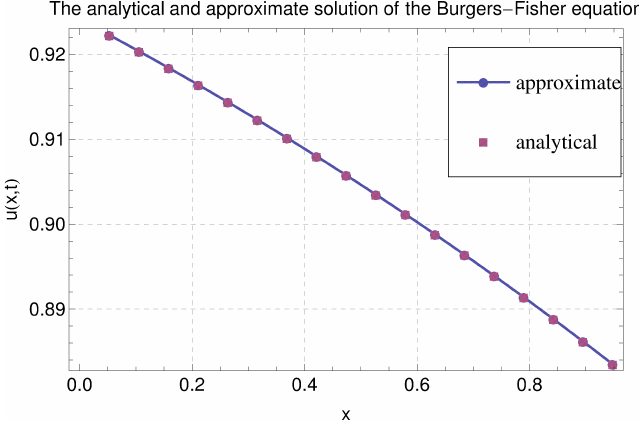
Fig. 2. Solution of Burgers-Fisher equation